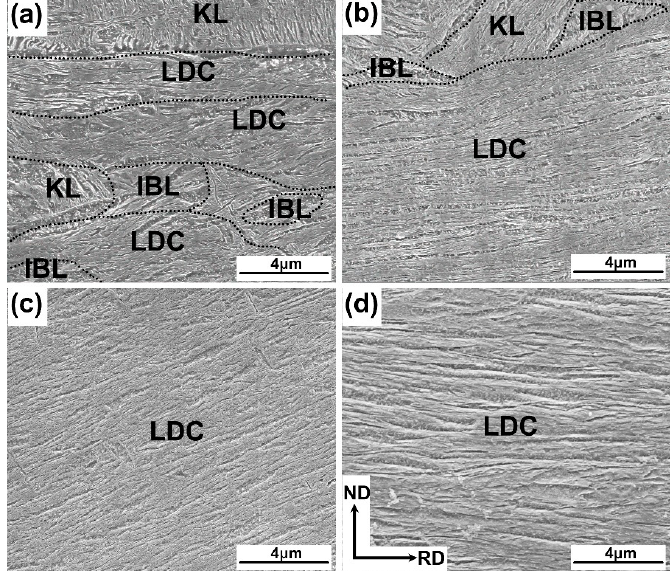
Figure 4. Scanning electron microscope (SEM) images showing the deformed martensite microstructure distinguished by three typical substructures with different reductions ( a ) 50%; ( b ) 60%; ( c ) 70%; and, ( d ) 80%.